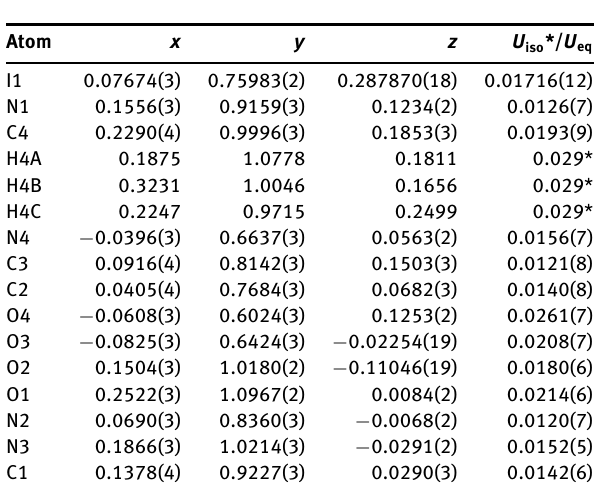
Table 2: Fractional atomic coordinates and isotropic or equivalent isotropic displacement parameters (Å 2